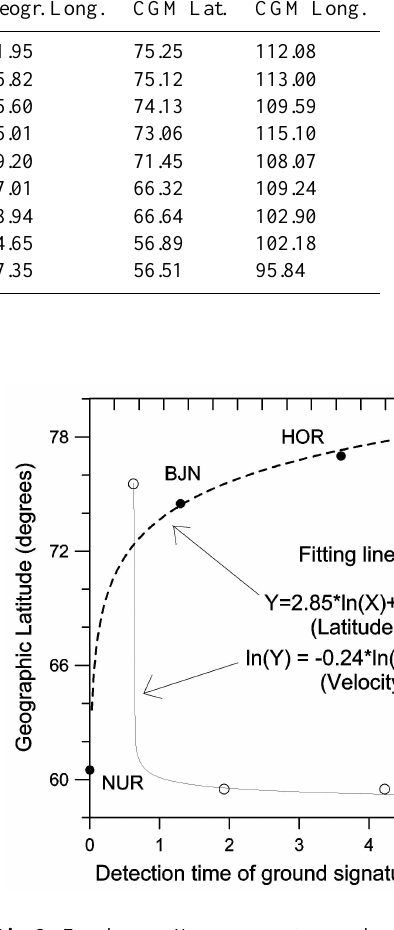
Fig. 2. For the five X-component ground magnetograms of Fig. 1 the arrival times for each signature are shown versus the station lat- itudes (solid circles). The arrival time at NUR station is considered as reference. The nonlinear character of the fitting line shown is apparent: the time delay for the highest latitude stations is very sen- sitive to latitude variations. The computed ground signature veloci- ties are shown with open